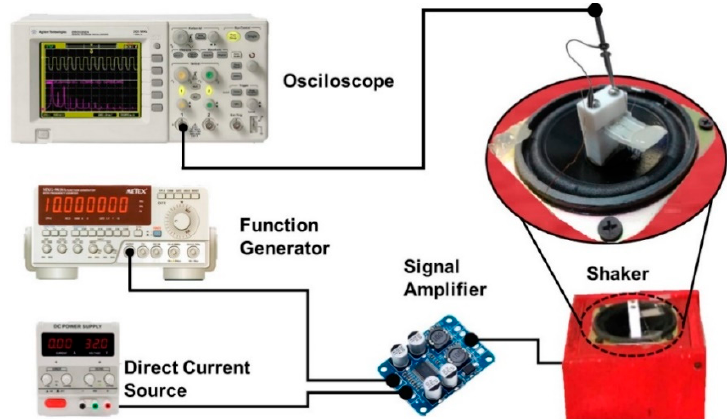
Figure 1. Schematic view of the experimental setup to measure the output voltage of the piezoelectric vibrational energy harvesting (pVEH) microdevice.